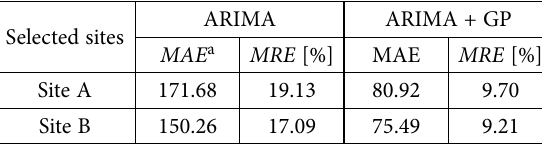
Table 12. Comparison of the predictive performance of the ARIMA and hybrid models in Scenario 2 Selected sites